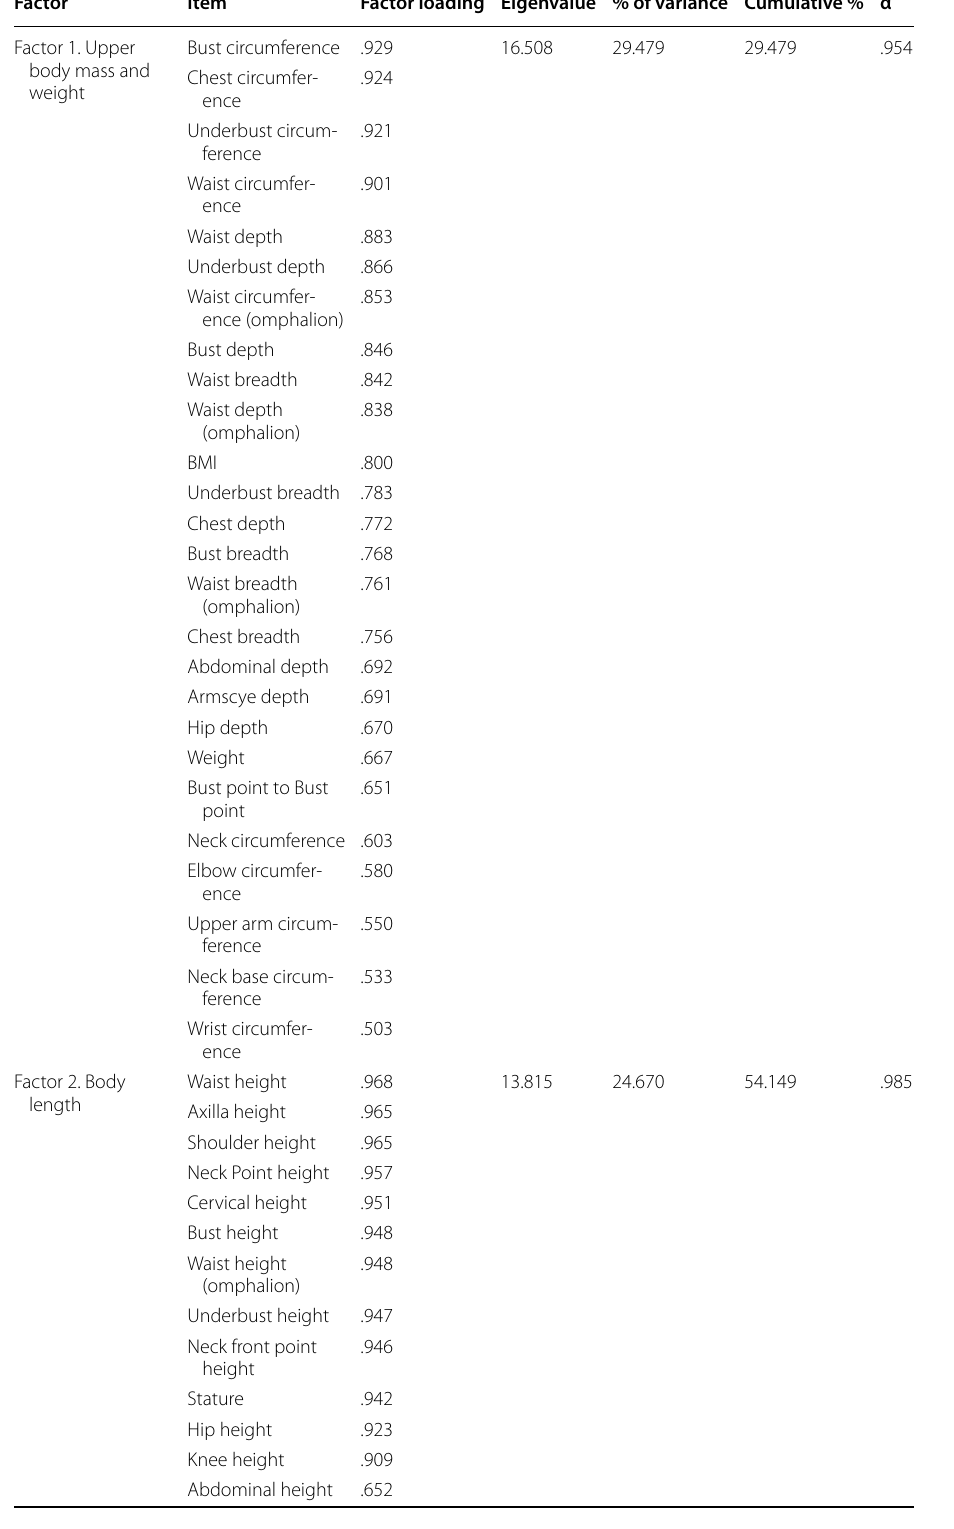
Table 4 Factor analysis of body measurements Factor Item Factor loading Eigenvalue % of variance Cumulative % α Factor 1. Upper Bust circumference body mass and weight